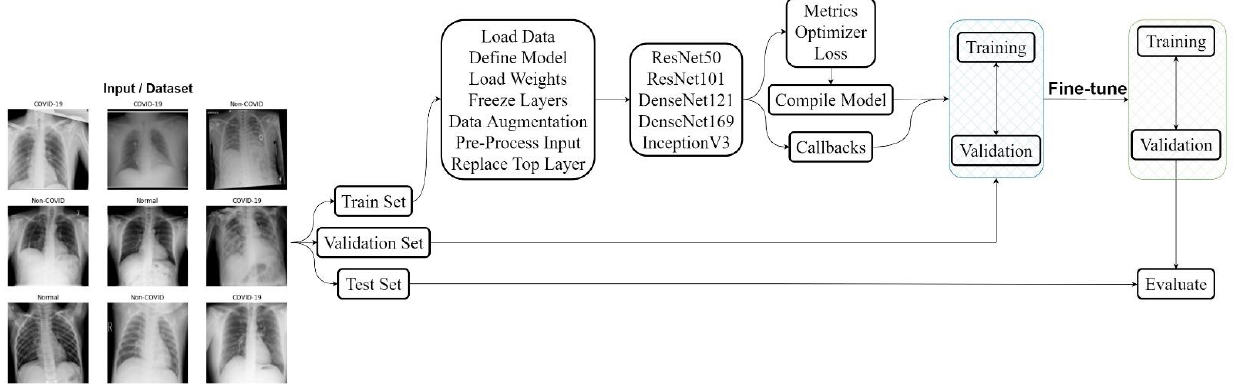
Figure 1. The proposed pipeline of this